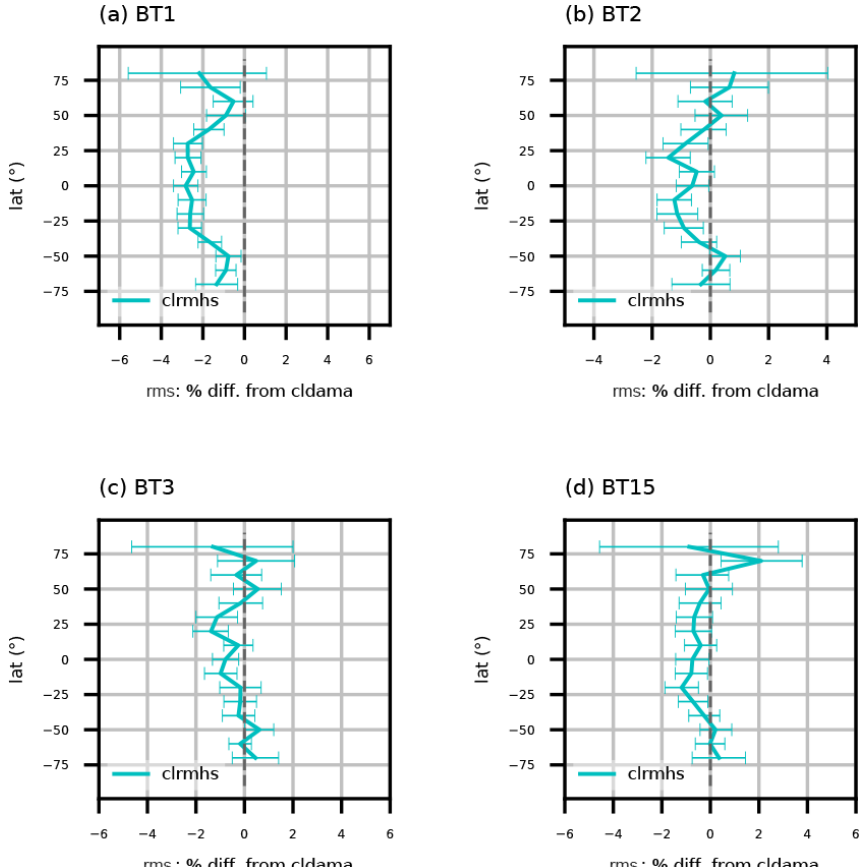
Figure 4. Similar to Fig. 3 but for latitudinal variation of relative rms reduction of OMB for NOAA-19 AMSU-A ch. 1–3 and 15 for clrmhs versus cldama